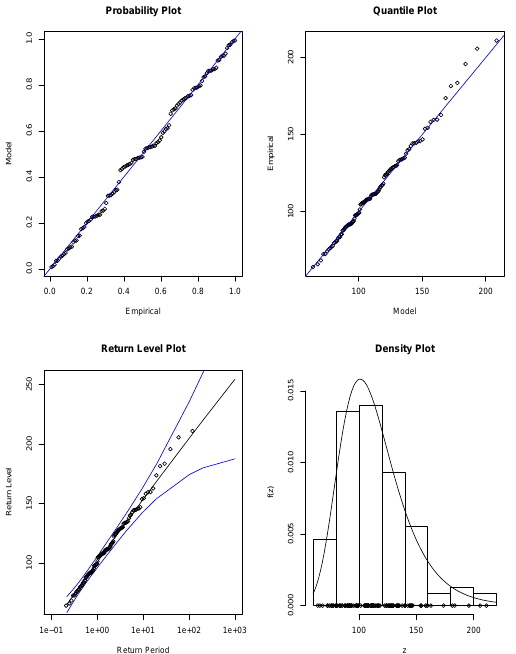
The shape parameter ( − 0.012) for the model, M 0 , in (28) indicates that the rainfall data for Eastern Cape can be modelled by the Weibull class of distributions since the shape parameter ξ < 0. The diagnostic plots for the stationary GEVD model in (28) are presented in Figure 3. The diagnostic plot results in Figure 3 show that the stationary GEVD model, M 0 , is the best fit for the Eastern Cape monthly rainfall data.